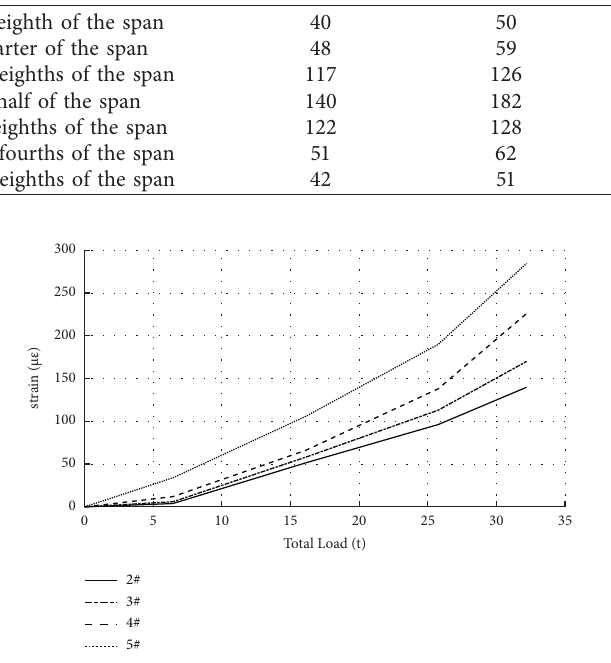
Figure 12: Strain history of normal loading tension side (measuring points 4–6#). Table 9: Stress and strain measurements under ultimate loading. Beam no.